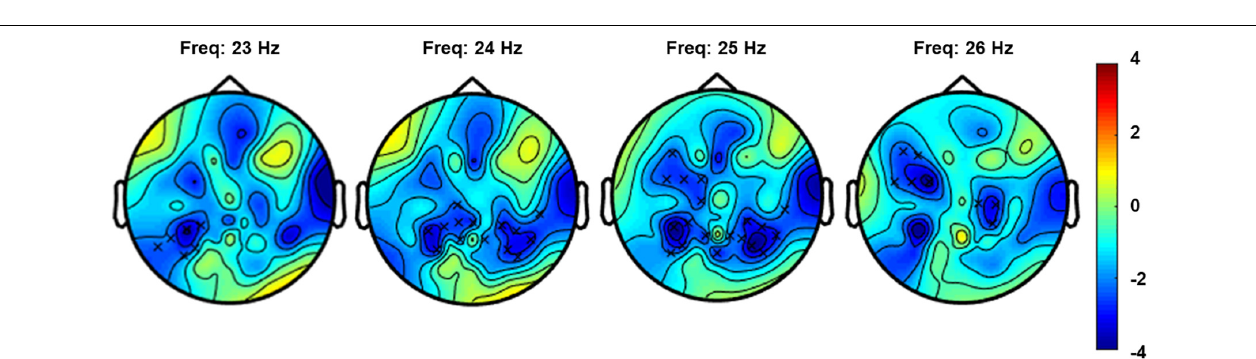
FIGURE 4 | Topoplot for the cluster-based permutation test that compared resting-state EEG power (4–30 Hz) before and after verum stimulation. The plot shows the negative cluster (indicated by the “x” markers) that demonstrated a significant difference between EEG power before and after PEMS, plotted on top of the t -statistic of the difference as calculated for every frequency-electrode pair (repeated-measures t -test). The cluster showed a significant difference most pronounced over bilateral central and left frontal regions and in the frequency range of 23–26 Hz.